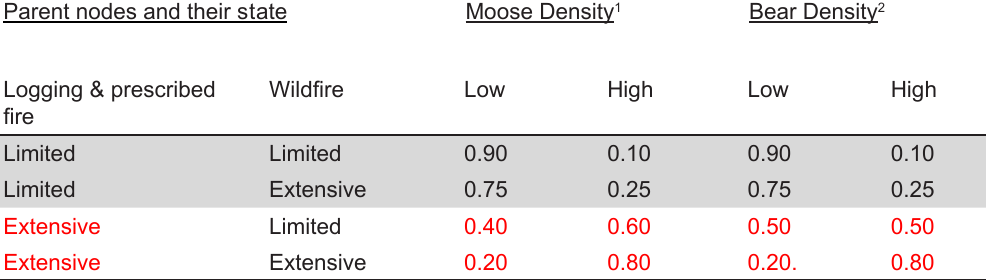
Table A8. Conditional probability table for nodes moose density and bear density. Parent nodes and their state